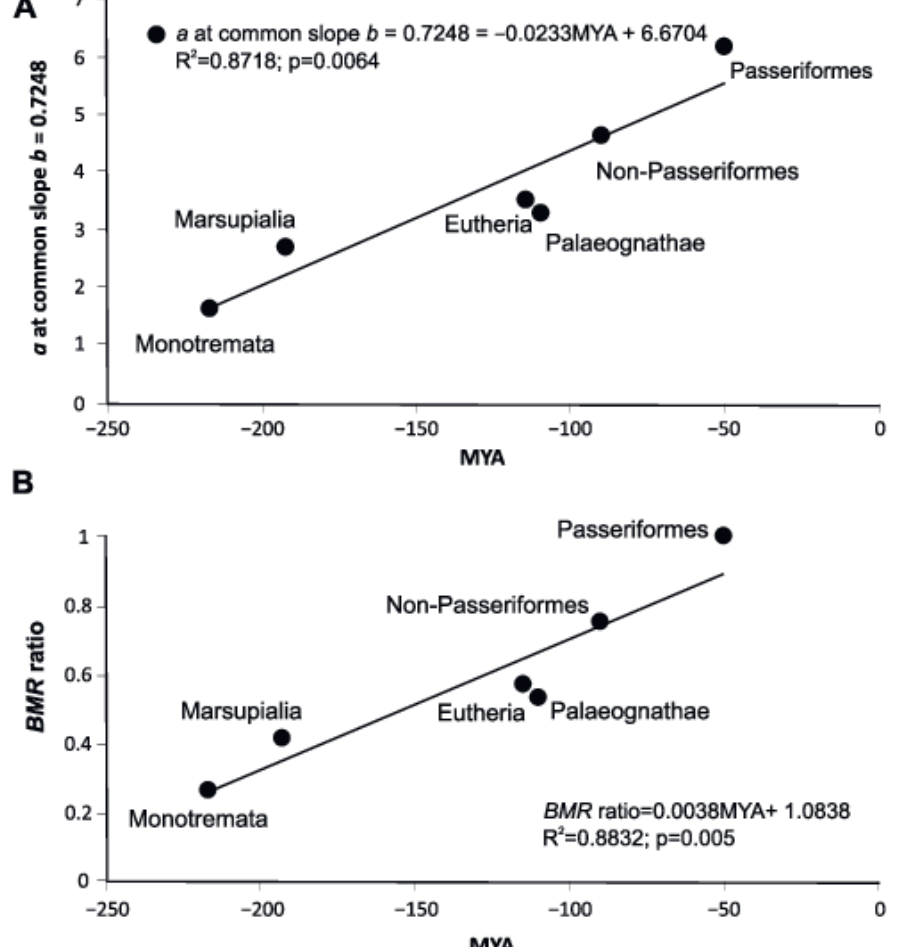
Figure 5. ( A ) The allometric coefficient a in different groups, after recalculation of the equations and transforming with a common average b = 0.7248 using the normal OLS procedure depending on the geologic time of divergence of the clades. ( B ) BMR level represented as BMR ratio in the six major groups of endothermic animals depending on the geological time of appearance of the group in evolution. MYA—million years ago.